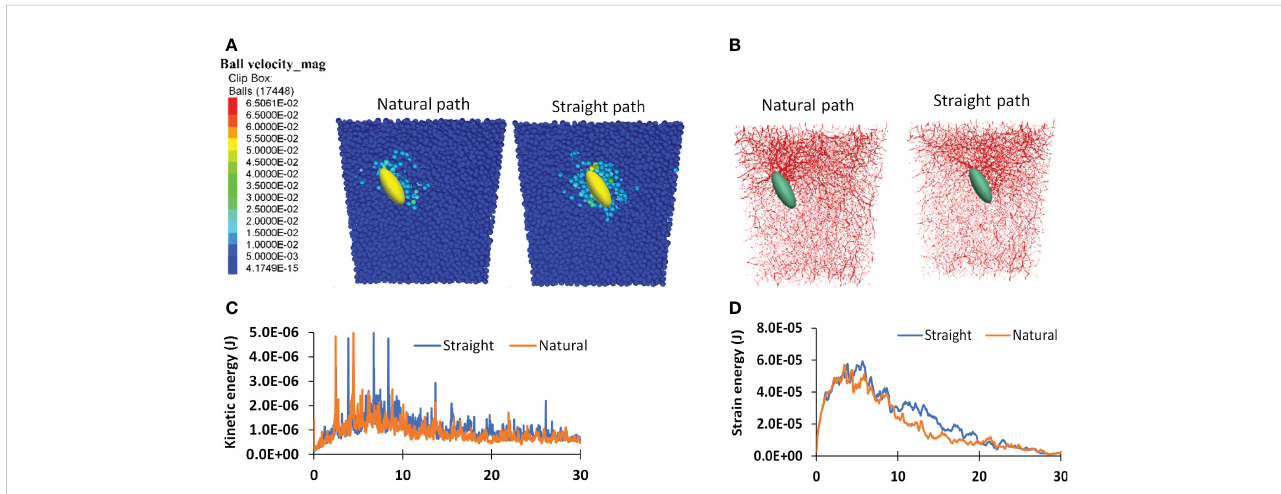
FIGURE 11 Simulated dynamic attributes for two scenarios: natural path and straight path. (A) Particle velocity contours of medium particles. (B) contact force chains within the medium particles. (C, D) Kinetic and strain energies of the system